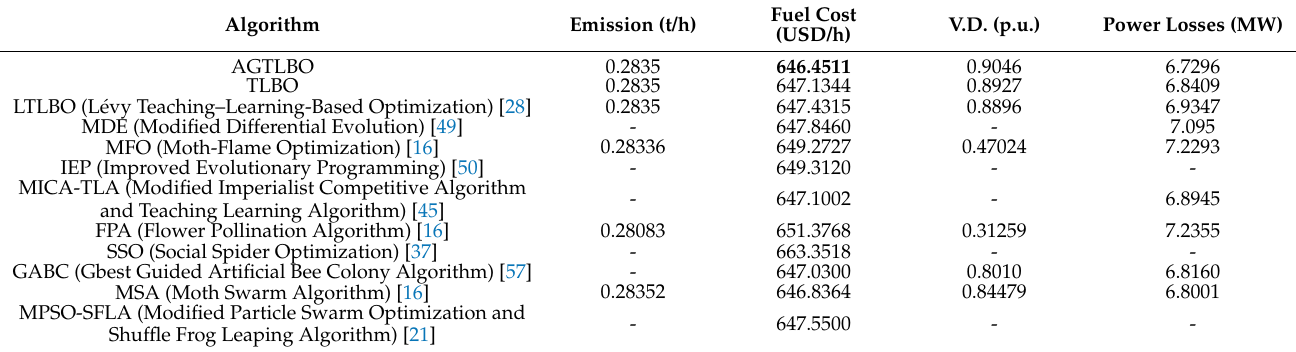
Table 3. Optimal results by different algorithms for Case